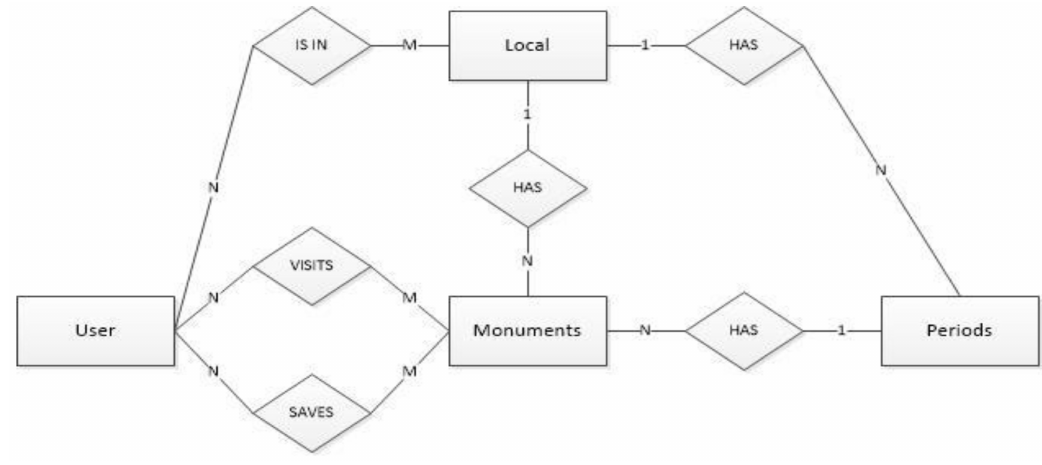
Figure 10. Entity Relationship diagram of the database.